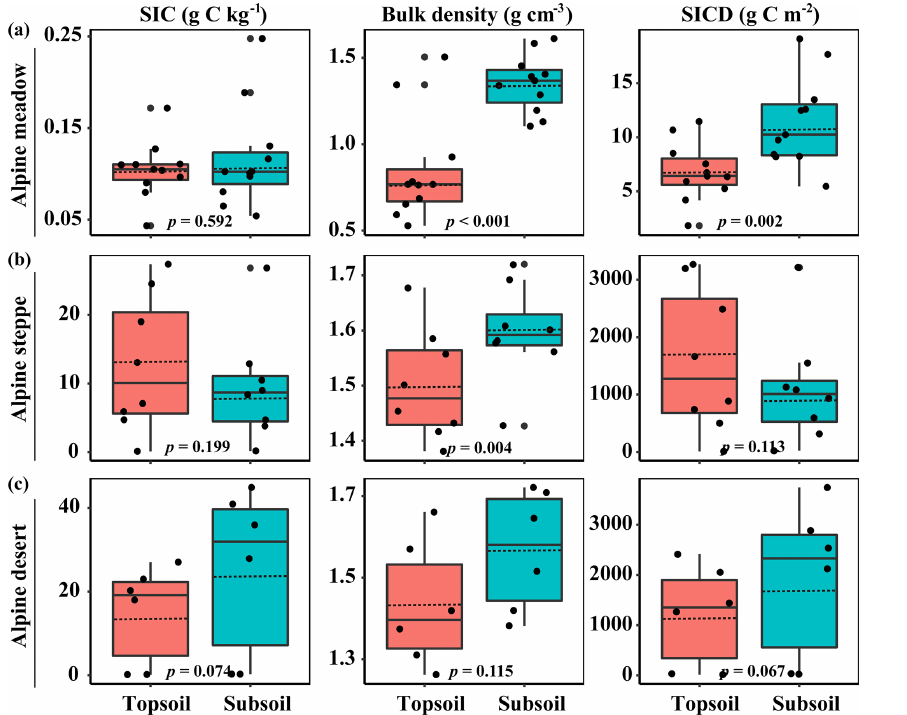
Figure 1. Soil inorganic C (SIC) content, bulk density (BD), and SIC density (SICD) in the topsoil and subsoil. The horizontal solid and hollow lines inside each box represent medians and mean values, respectively. Significant differences between the topsoil and subsoil were inspected according to Tukey’s test. Table 1. Edaphic, plant and microbial properties between the topsoil and subsoil for 25 sampling